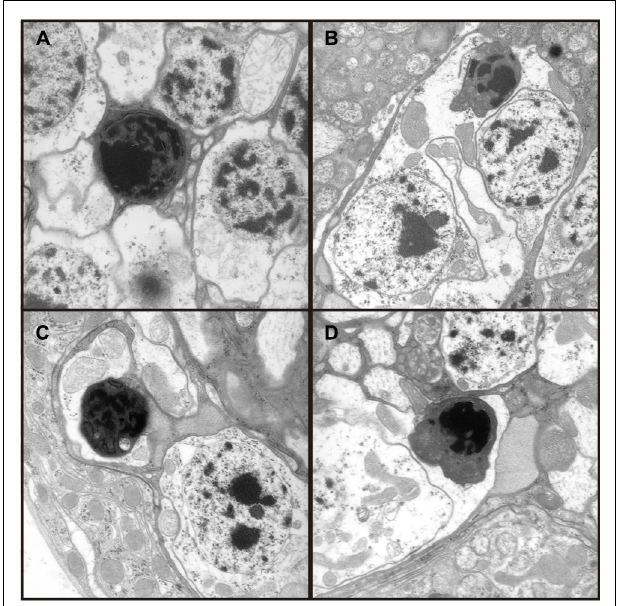
FIGURE 5 | (A–D) Four independent electron micrographs from Wolbachia infected flies showing characteristic apoptotic nuclei, suggesting neuronal death results from apoptosis.